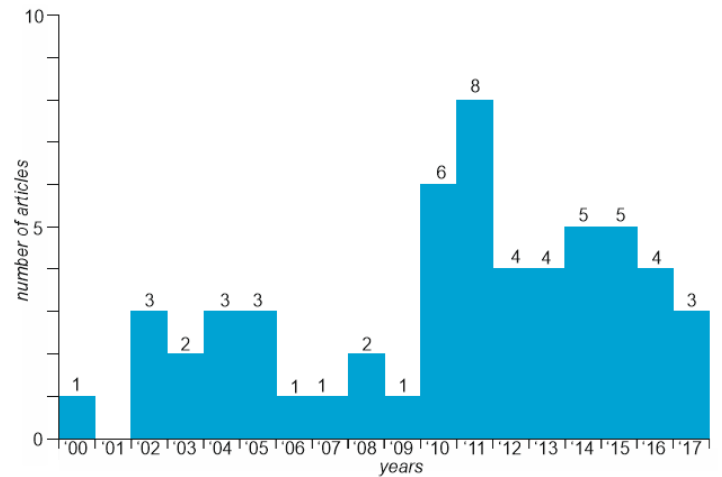
Figure 2. Dynamics of the megaclast-related publishing activity during 2000–2017 (created by authors).